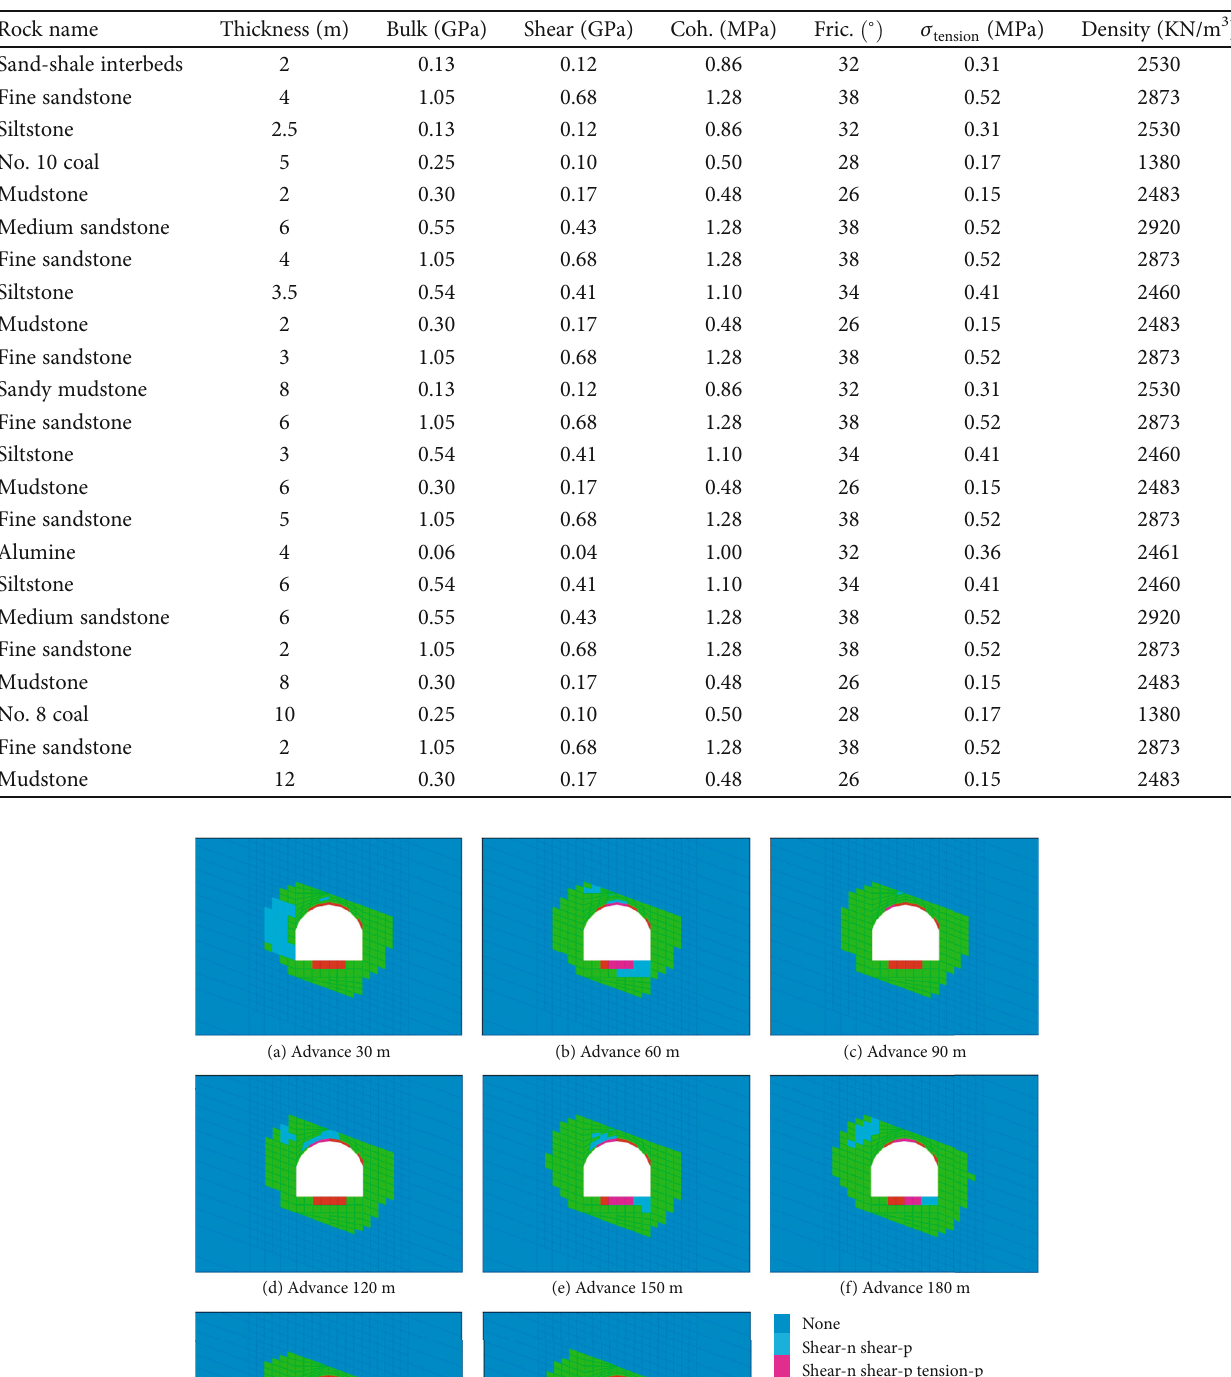
Table 1: Parameters of physical and mechanical properties of the model.